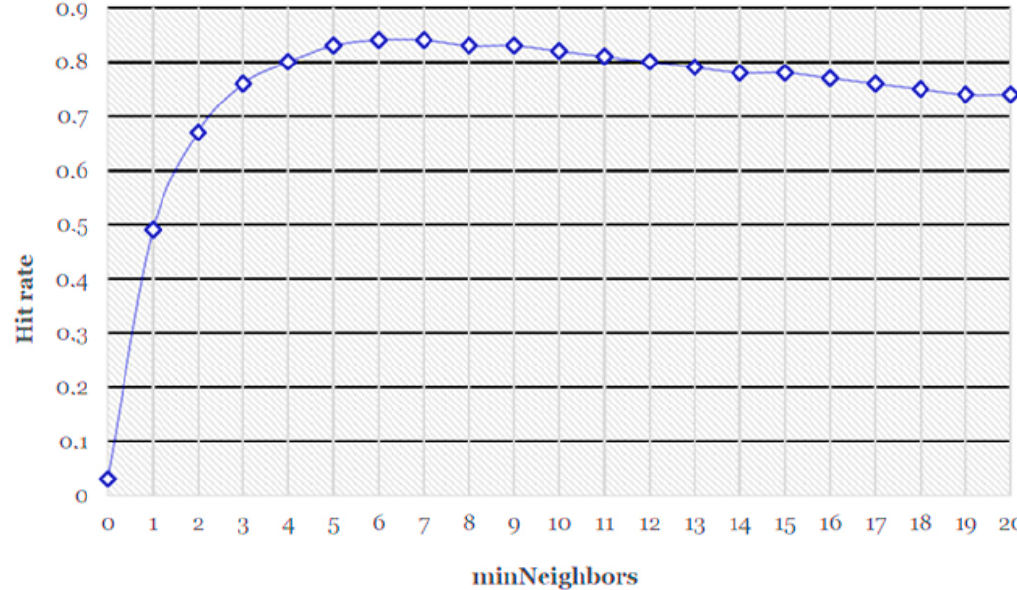
Figure 8. Hit rate with the scale factor (SF) = 1.25: the best values are between the hit rates 0.8 and 0.9. In Figure 9, the results of banknote detection of the € 5, € 10, and € 50 banknotes are shown. In Table 1, the banknote detection matrix of confusion is represented.